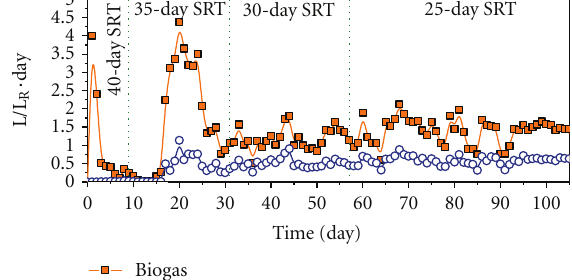
Table 4: Initial organic loading rate (OLR 0 ) for each SRT.